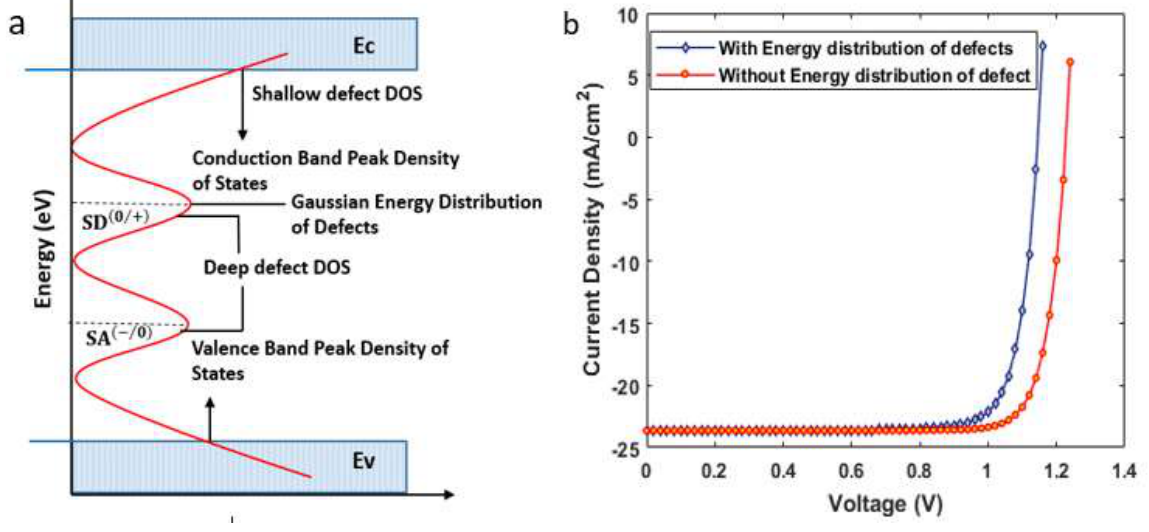
Figure 7. ( a ) Density of state (DOS) of the semiconductor material; ( b ) current density–voltage characteristics for the solar cell with and without adoption of energy distribution of defects . Table 1. Device output characteristics with adoption of energy distribution of defects .